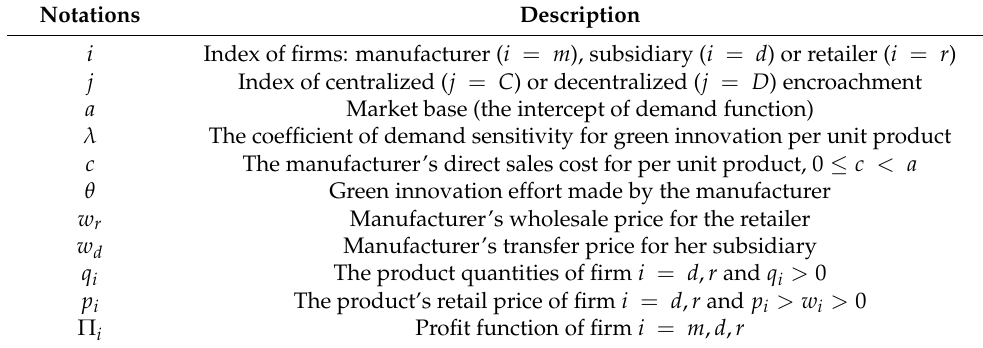
Table 1. Notations